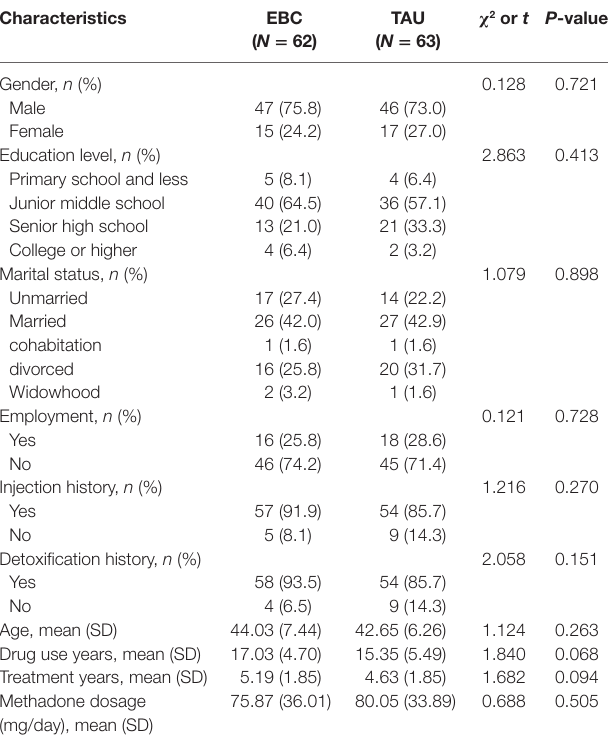
TaBlE 1 | Characteristics of participants in educational and behavioral counseling (EBC) and treatment as usual (TAU) groups. Characteristics χ 2 or t P -value